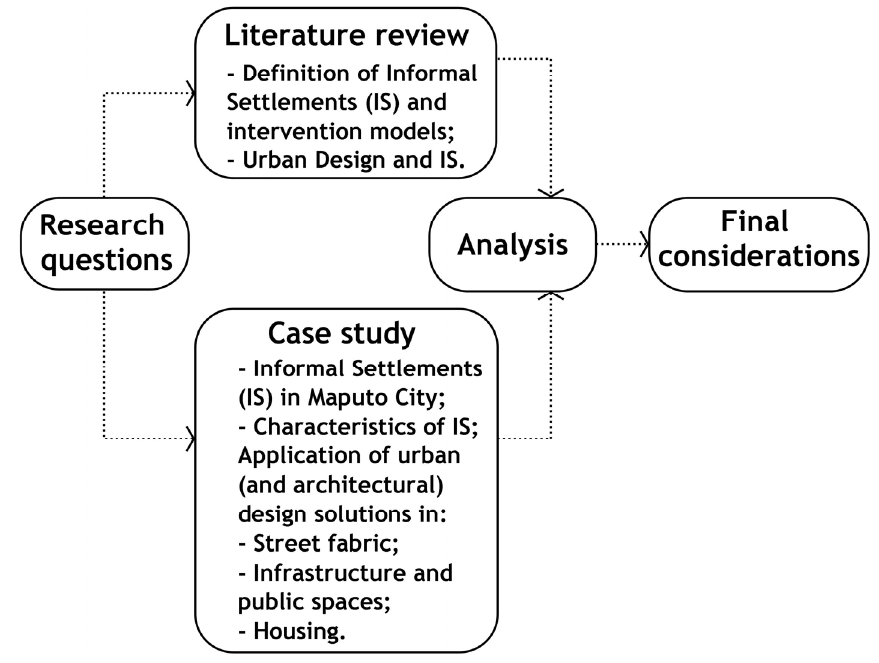
Figure 1. Diagram of the methodological process of the research.